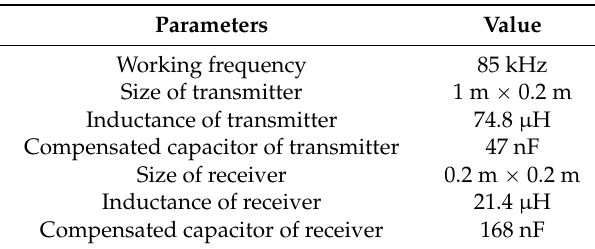
Table 2. Specific parameters of the designed prototype.